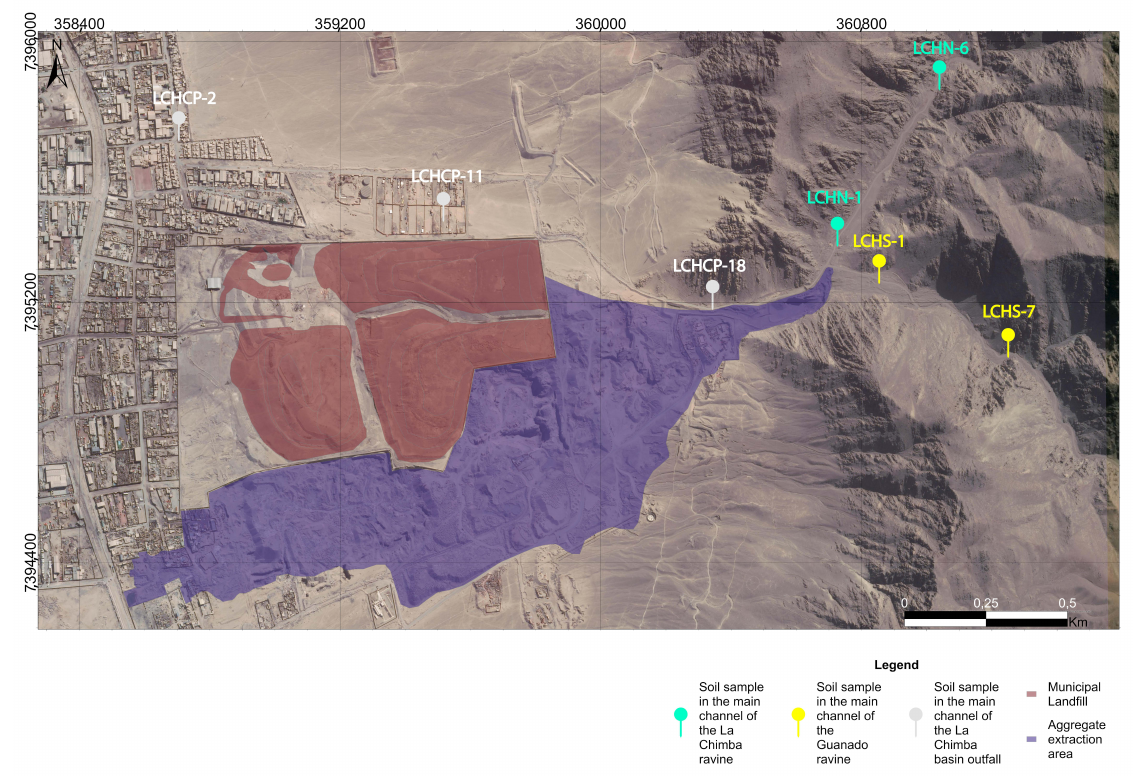
Figure 4. Location of pits and soil samples in the study area. The white points and codes indicate samples from the mouth area, light blue points indicate Guanaco sub-basin samples and yellow colors indicate La Chimba sub-basin samples. The brown color represents the Municipality Dump. The purple area represents a sedimentary material extraction zone and ground